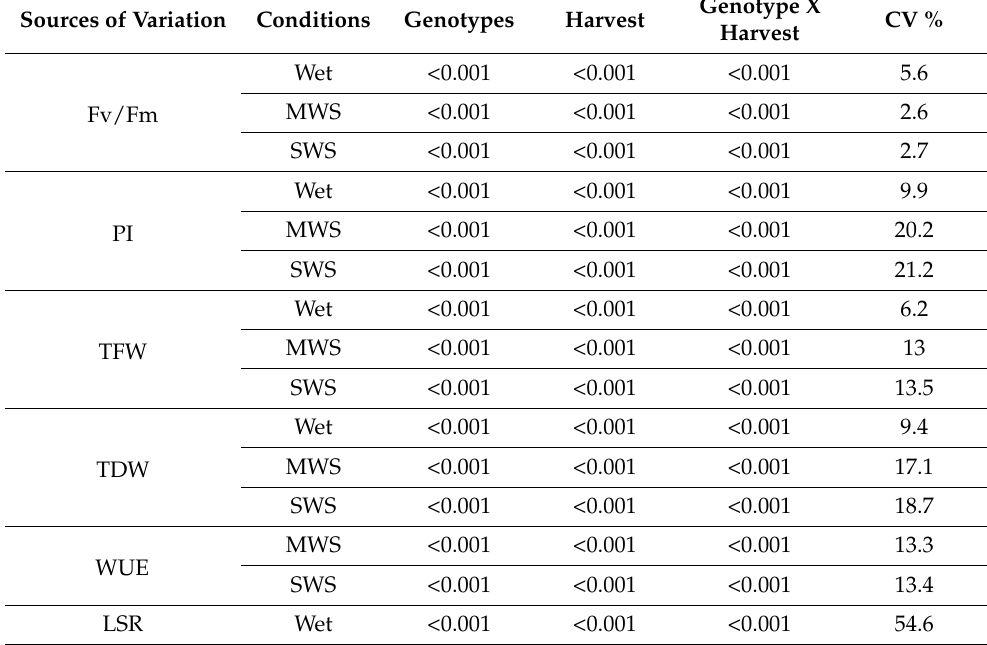
Table A2. Cont. Sources of Variation Conditions